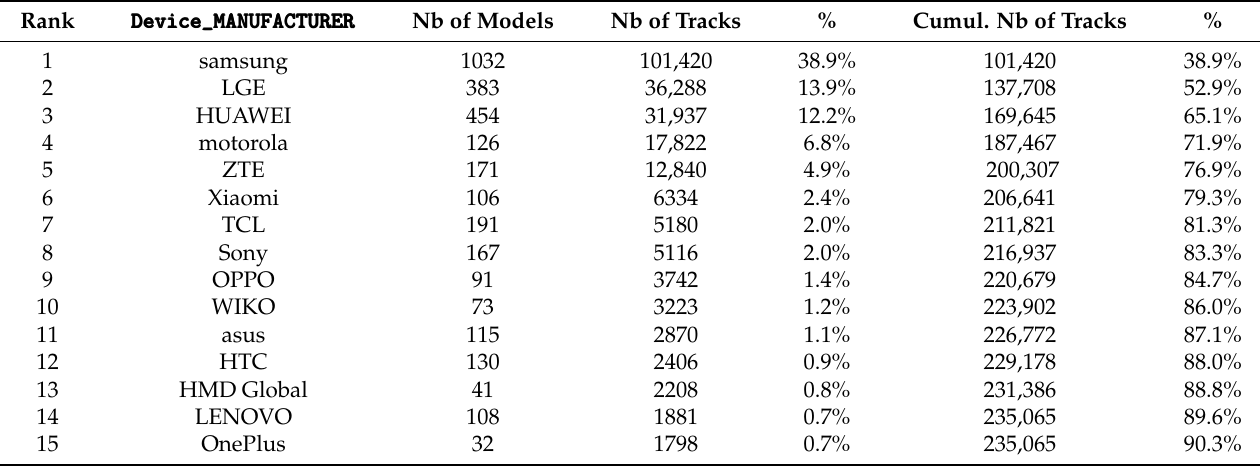
Table 4. Top 15 of smartphone manufacturers ( ‘device_manufacturer’ , case insensitive) in the NoiseCapture database. The number of corresponding distinct device models ( ‘device_model’ ), the number of tracks, as well as the cumulative number of tracks are also given. Note that this table do not regroup data from the same manufacturer but with a different writing (upper/lower case, as for ‘Samsung’ and